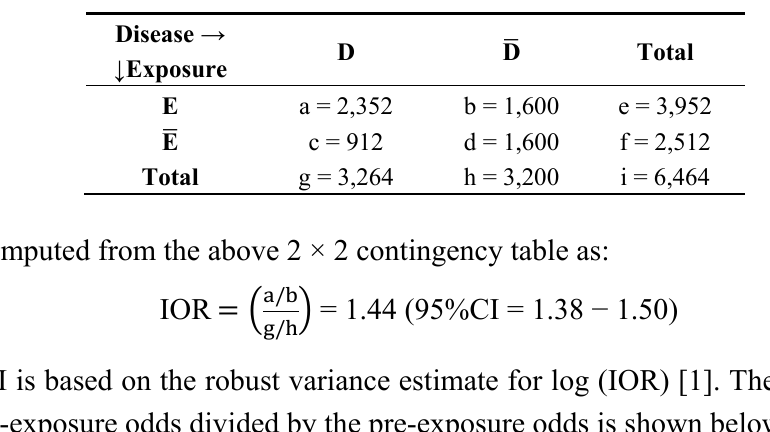
Table 1. A 2 × 2 contingency